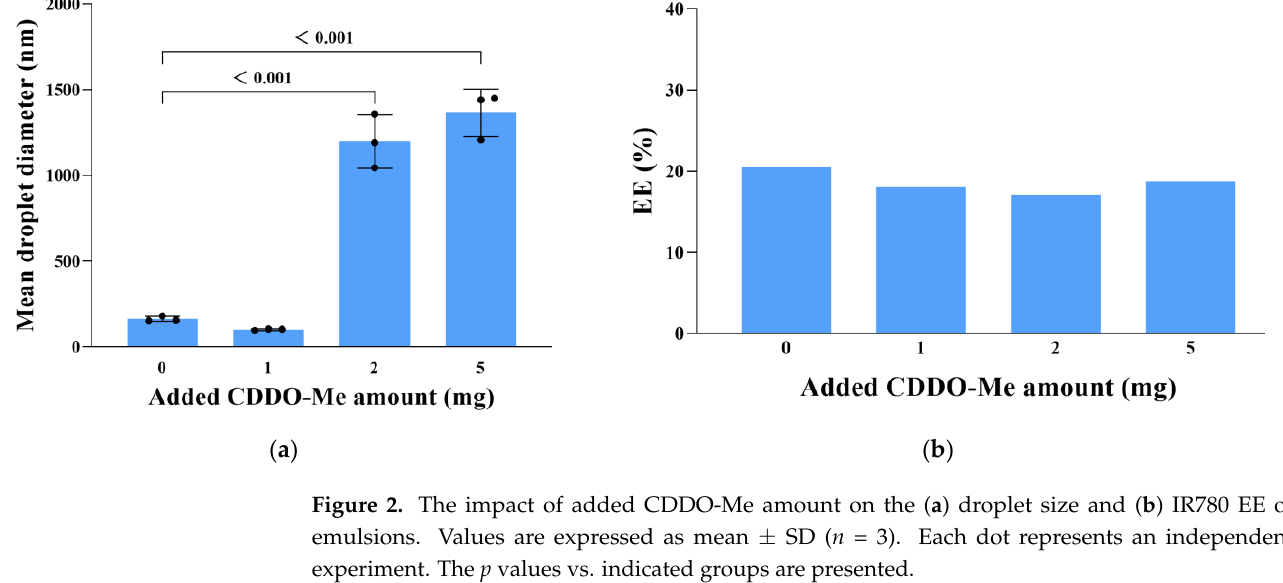
Figure 2. The impact of added CDDO-Me amount on the ( a ) droplet size and ( b ) IR780 EE of emulsions. Values are expressed as mean ± SD ( n = 3). Each dot represents an independent experiment. The p values vs. indicated groups are presented.